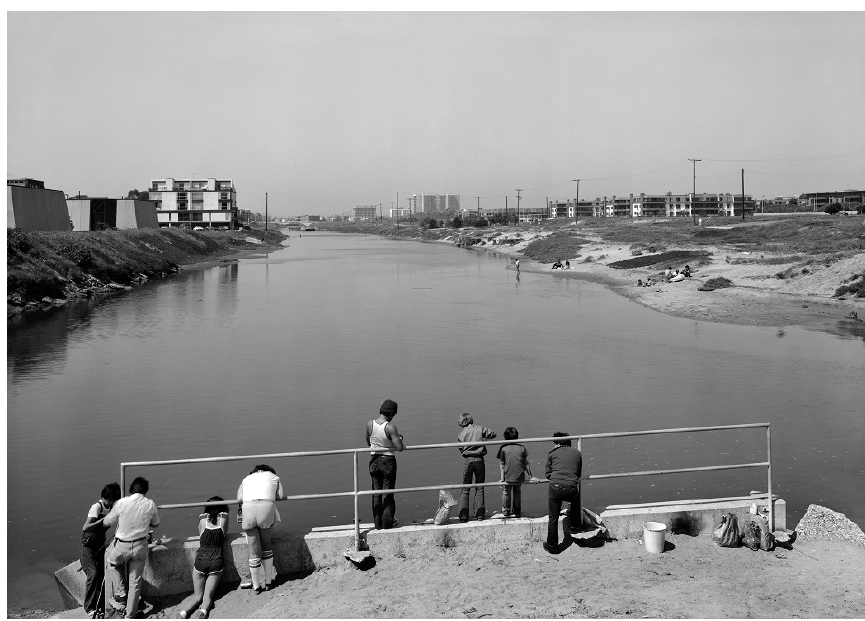
Figure 16. Anthony Hernandez, Public Fishing Areas #30 (1979), © Anthony Hernandez.